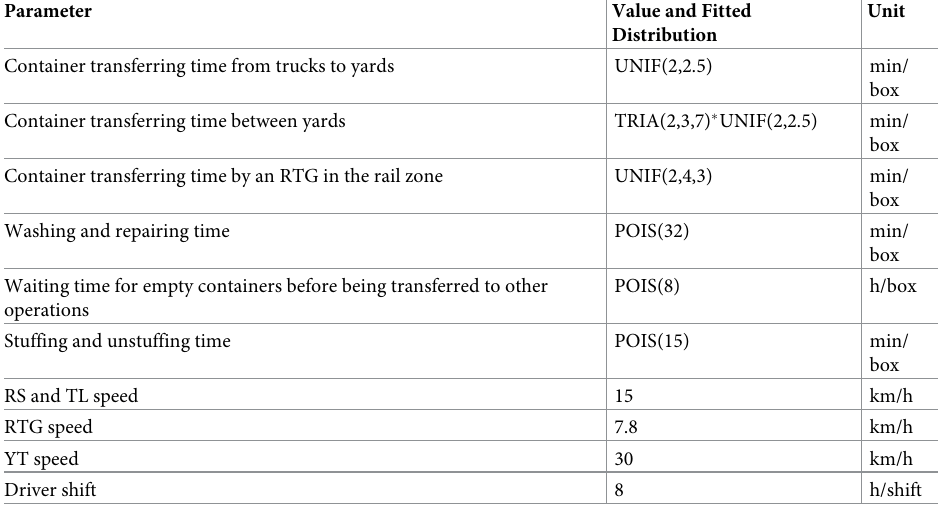
Table 1. Main parameters extracted from the information provided by SRT and